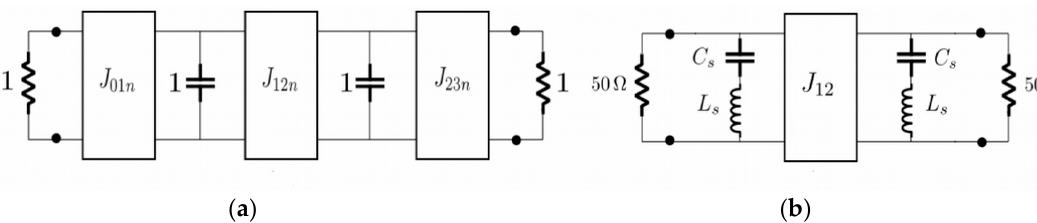
Figure 11. Equivalent circuits used for the synthesis of the second order band-stop filter. ( a ) Normalized low-pass prototype with admittance inverters; ( b ) final circuit after performing the low-pass to band-stop frequency transformation. Normalized loads are absorbed with first and last inverters and the whole circuit is scaled for 50 Ω ports impedance.